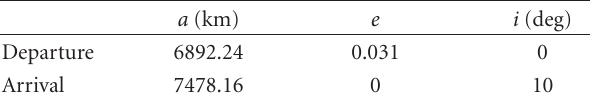
Table 2: Parameters of departure and arrival